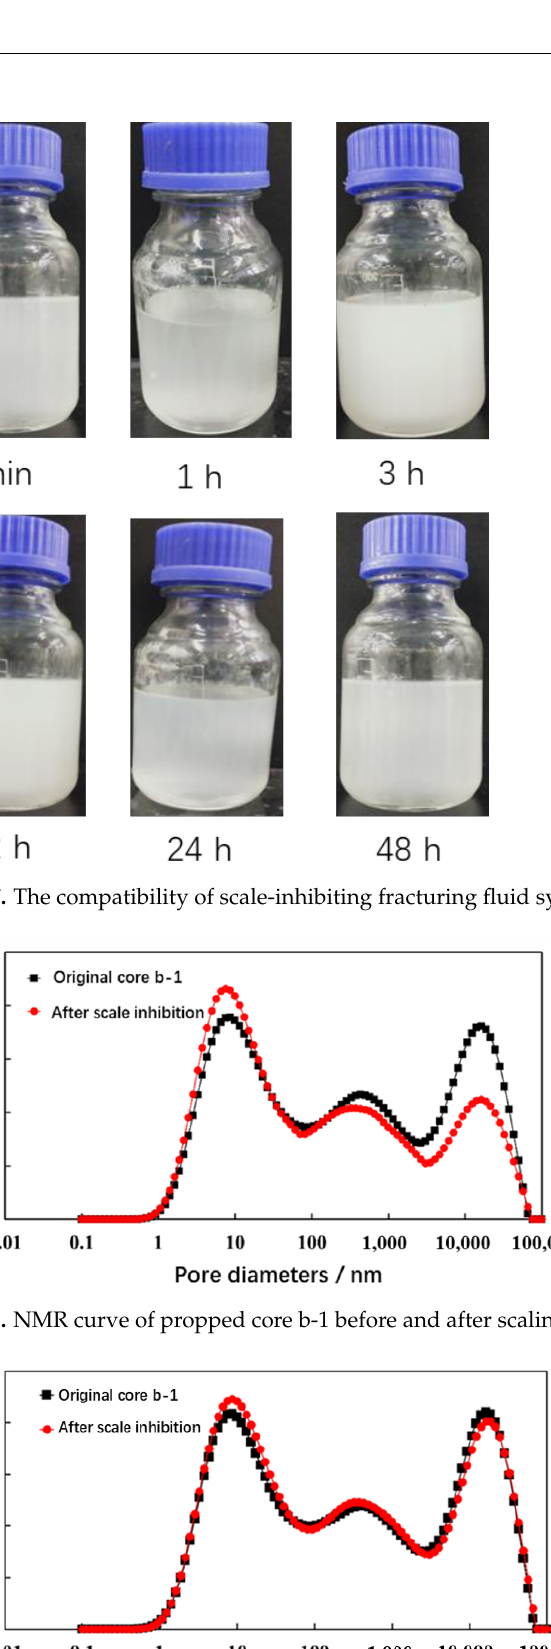
Table 5. Calculation of damage rate and scaling-inhibition rate by NMR. Integral Area of Core Relaxation Signal Damage Rate/% Scale-Inhibi- tion Rate/% Original Core